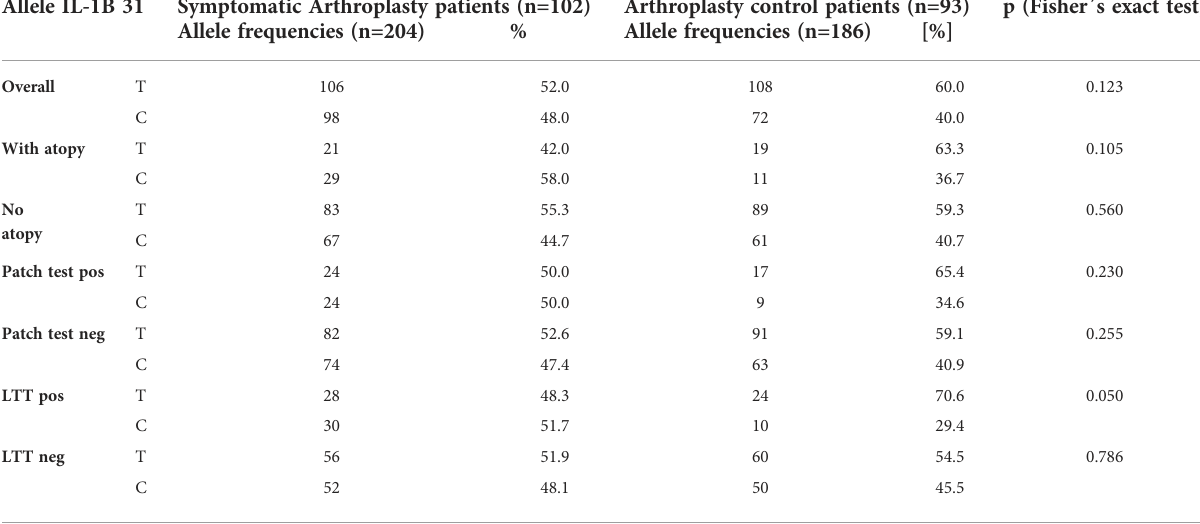
TABLE 5 Allele frequencies of the IL-1B-31 polymorphism including also subgroup analysis.